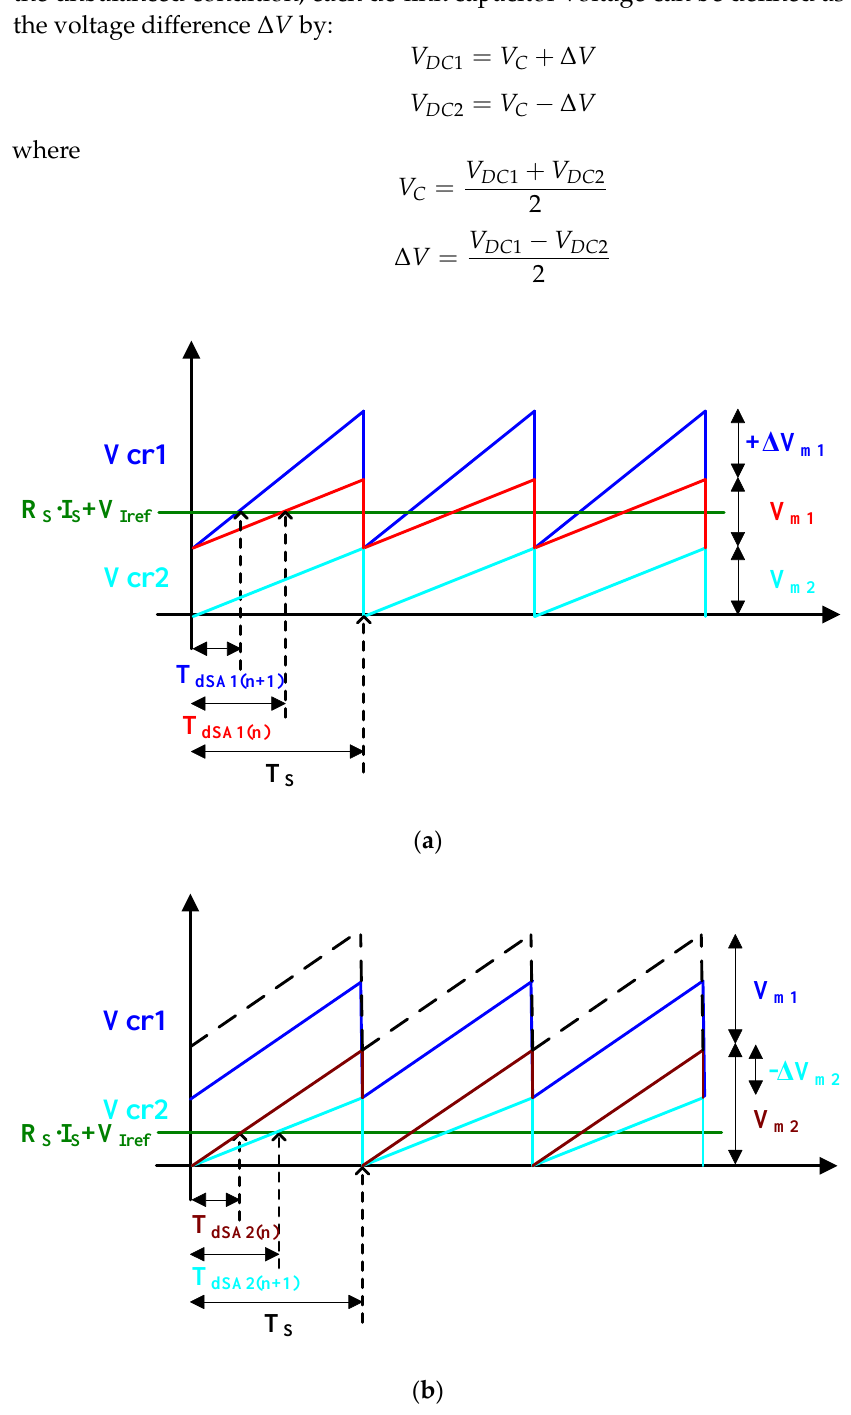
Figure 5. Proposed four-carrier level-shifted OCC PWM control of the proposed five-level STATCOM in region I and II. ( a ) Vcr 1 carrier signal modulation when V DC 1 > V *DC ; ( b ) Vcr 2 carrier signal modulation when V DC 2 < V *DC .